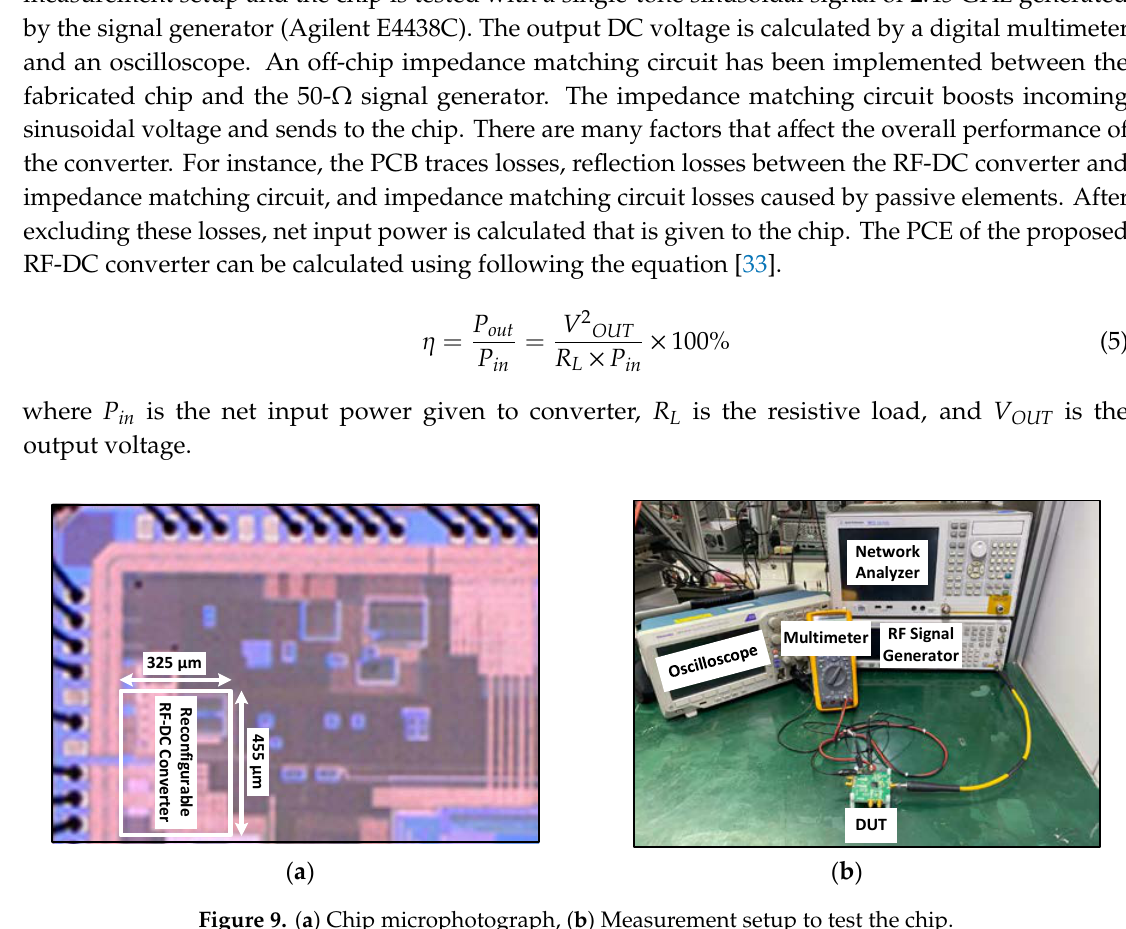
Figure 9. ( a ) Chip microphotograph, ( b ) Measurement setup to test the chip.